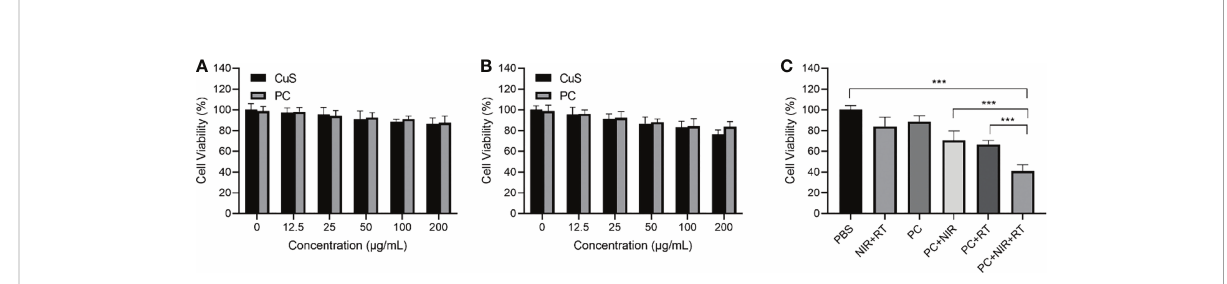
FIGURE 3 Cell viability of CT 26 cells (A) and FHC cells (B) after incubation with various doses of CuS and PC. Cell viability after treatment including control, NIR+RT, PC only, PC+NIR, PC+RT, and PC+NIR+RT (C) . ***p <